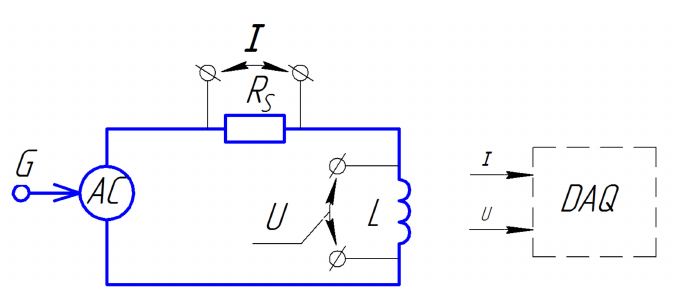
Figure 1. Schematic representation of the measurement